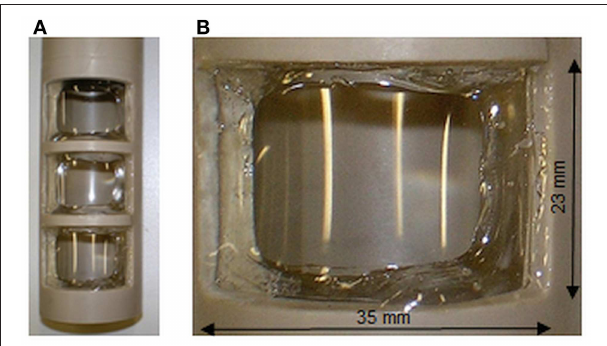
FIGURE 2 | Detailed views on the inlay (A) and on one window (B) with the glued membrane. Dimensions provided refer to the window opening; the active membrane surface is diminished by glue edges to 716 mm 2